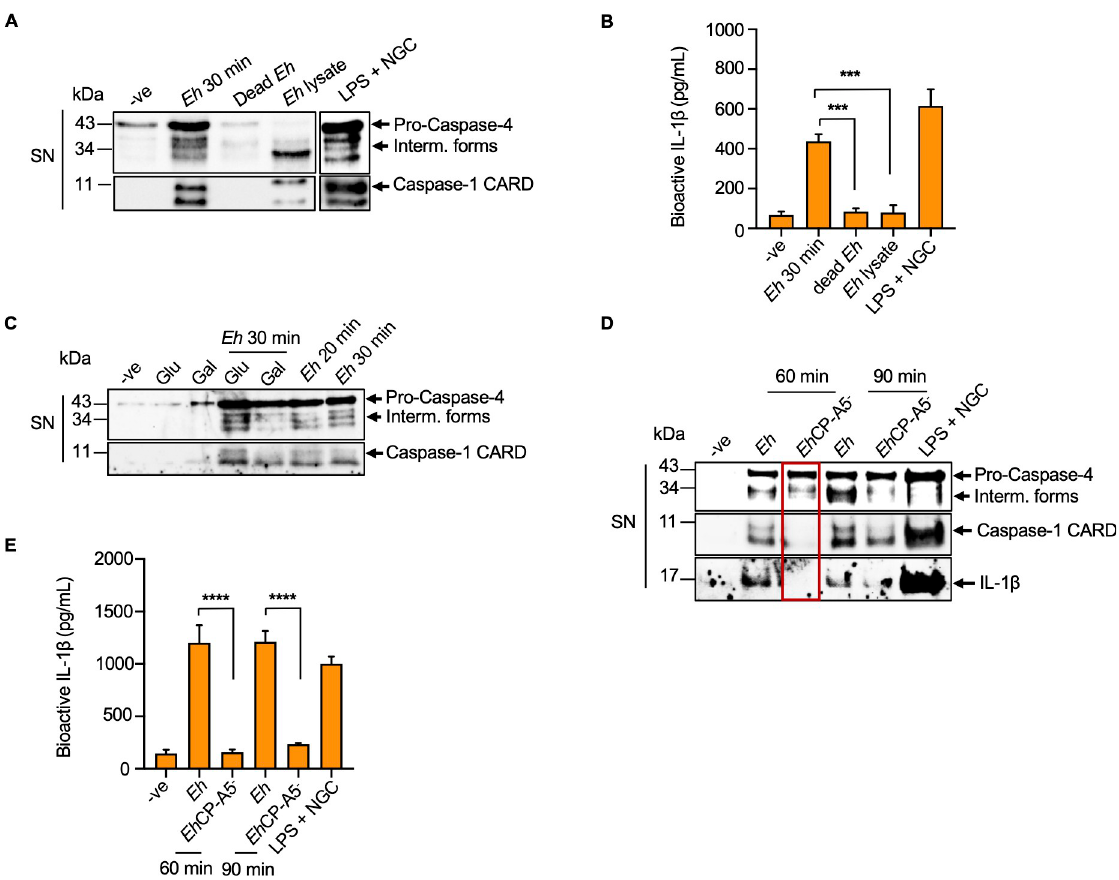
Fig 2. E . histolytica -macrophage contact is required for caspase-4 activation. ( A, B ) Macrophages were incubated with live Eh : macrophage ratio (1:20), fixed Eh : macrophage ratio (1:20) for 30 min and with equivalent amount of freeze thawed whole lysates of Eh . Live Eh were fixed with 1.5% glutaraldehyde for 1 h at 4˚C and washed 3 times with sterile cold PBS before use. LPS (50 ng/mL) and NGC (10 μ M) stimulation for 60 min acted a positive control. Post incubation, the cell supernatant (SN) was TCA precipitated and equal amount was loaded onto the SDS-PAGE gel to detect caspase-4/1 activation with indicated antibodies. ( B ) Cell supernatant was added to HEK-Blue IL-1 β reporter cells to detect bioactive IL-1 β using the SEAP assay. Statistical significance was calculated between live Eh and fixed (dead) Eh , and between live Eh and Eh lysate ( C ) Macrophages were pretreated for 5 min with 55 mM D-galactose (Gal), or glucose (Glu) as an osmotic control and then incubated with Eh for 30 min at a 20:1 ratio. ( D ) Macrophages were incubated with Eh , and Eh deficient in CP5 ( Eh CP-A5 - ) for 60 min and 90 min, respectively. LPS (50 ng/mL) and NGC (10 μ M) stimulation for 60 min were used as a positive control. ( E ) Cell supernatant was added to HEK-Blue IL-1 β reporter cells to detect bioactive IL-1 β using the SEAP assay. Statistical significance was calculated between WT Eh and Eh CP-A5 - Eh . Data and immunoblots are representative of at least three independent experiments (n = 3) and statistical significance was calculated with one-way ANOVA, followed by Bonferroni’s post-hoc test ( ��� p < 0.001, ���� p < 0.0001). Bars represent mean ±